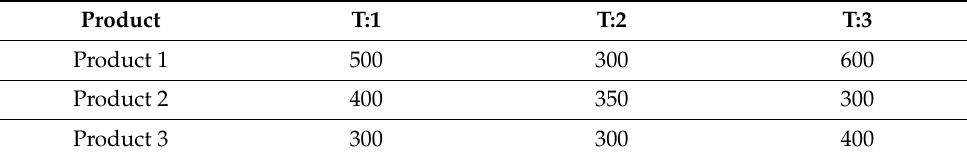
Table 13. Market demands of the case study (product units).